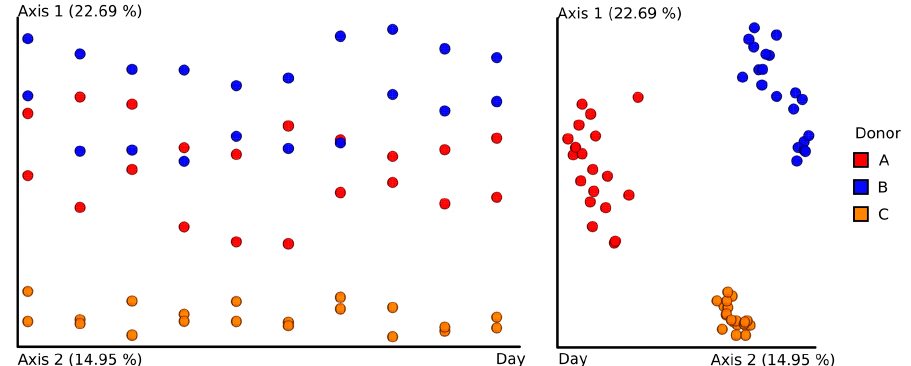
Figure7. Principalcoordinatesanalysis(PCoA)visualization. ThePCoAwasbuiltusingtheBray–Curtis Figure 7. Principal coordinates analysis (PCoA) visualization. The PCoA was built using the Bray– dissimilarity index with day of sample collection as one Curtis dissimilarity index with day of sample collection as one axis.